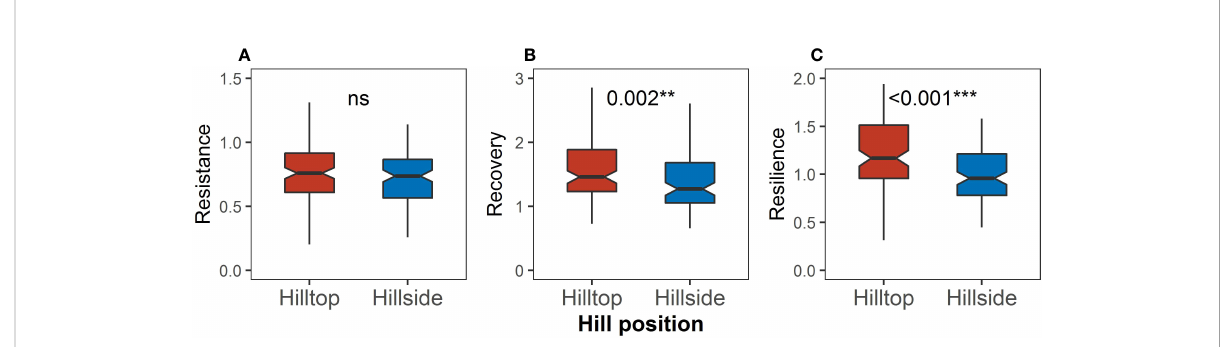
FIGURE 7 Differences in (A) resistance, (B) recovery, and (C) resilience between the hilltop and the hillside. Asterisks indicate signi fi cant differences between the hilltop and the hillside (Kruskal – Wallis rank sum test: **P < 0.01; ***P < 0.001). “ ns ” means no signi fi cant difference.